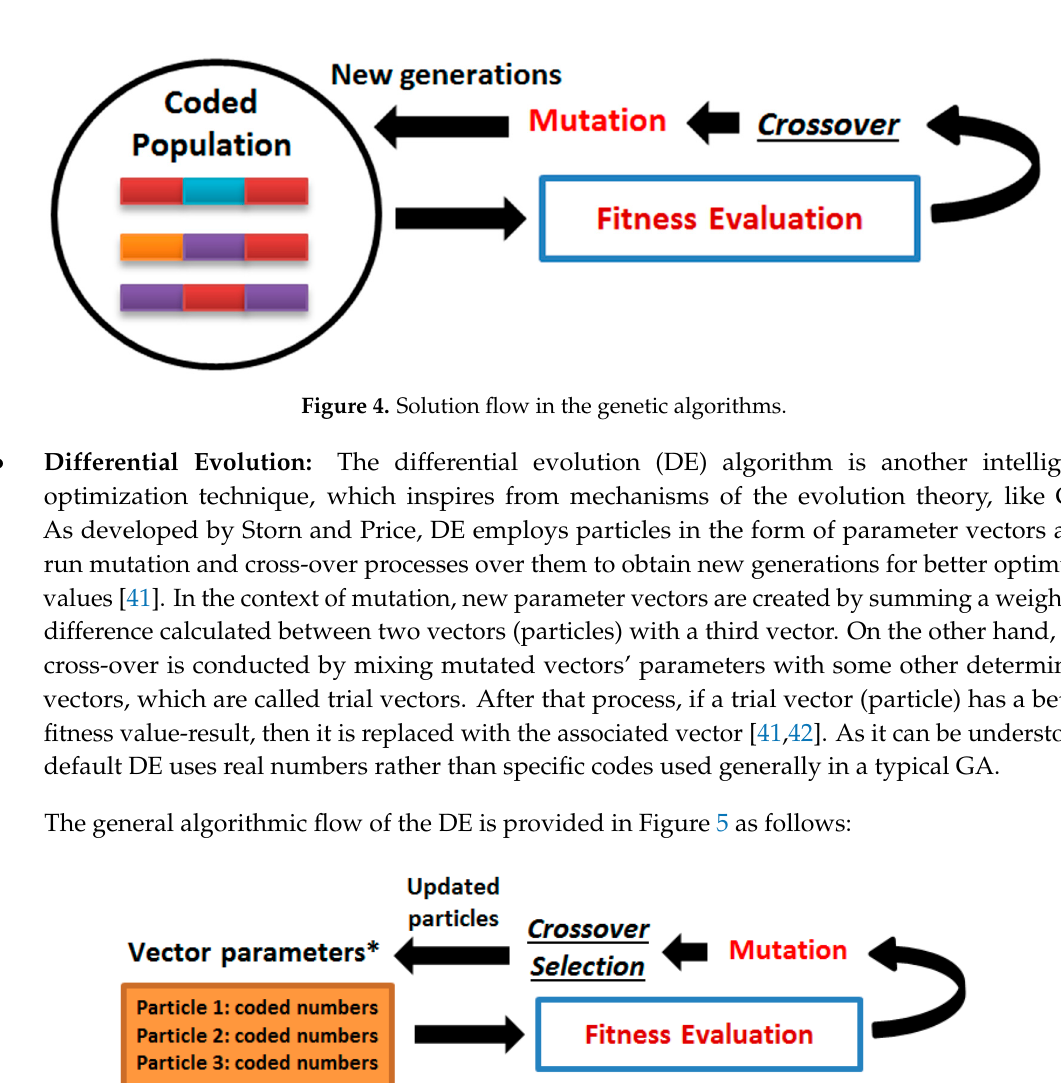
7 of 18 Figure 3. General solution flow of the cuckoo search algorithm. •